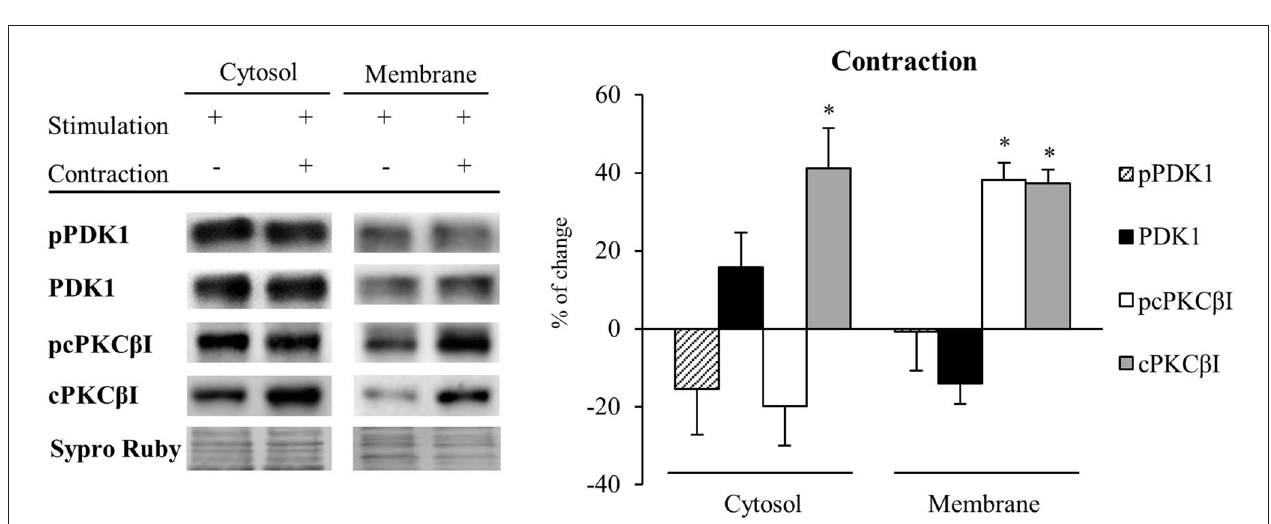
FIGURE 6 | Muscle contraction maintains PDK1 and pPDK1 levels but increase cPKC β I and pcPKC β I levels in the membrane fraction of skeletal muscle. PDK1 and pPDK1 after isolation of membrane and cytosol fractions in Contraction treatment at 1 Hz stimulation for 30 min. Each column has been compared to its respective control (see Table 1 ). We observed that muscle contraction increased cPKC β I protein levels in the cytosolic fraction but pPDK1, PDK1 and pcPKC β I levels remained the same. Thus, the ratio pPDK1/PDK1 was maintained while pcPKC β I/cPKC β I decreased due to the increase of the total protein. Moreover, in the plasma membrane, pPDK1 and PDK1 were also not modified but pcPKC β I and cPKC β I were significantly increased. Thus, the ratio pPDK1/PDK1 and pcPKC β I/cPKC β I in the membrane fractions remained the same. Data are mean percentage ± SEM, ∗ p < 0.05 ( n = 5). Abbreviations: phosphoinositide-dependent kinase 1;